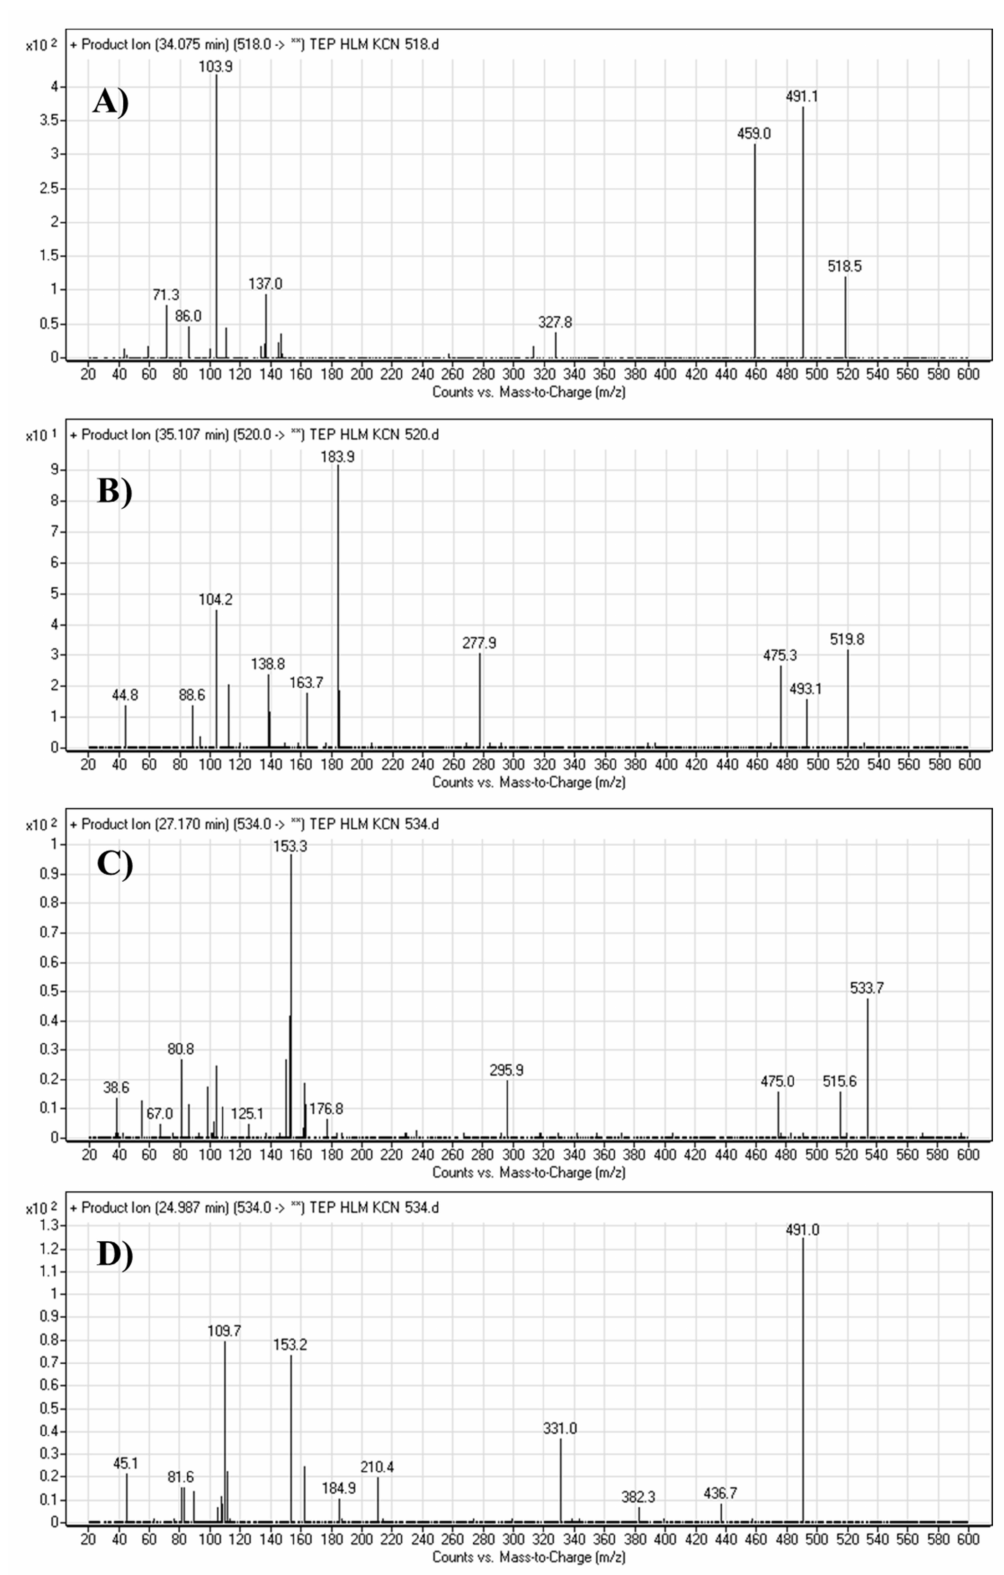
Figure 5. Fragment ions of cyano adducts: TEPCN518 ( A ), TEPCN520 ( B ), TEPCN534a ( C ) and TEPCN534b ( D ) generated in the in vitro metabolism of TEP in the presence of KCN as a trapping